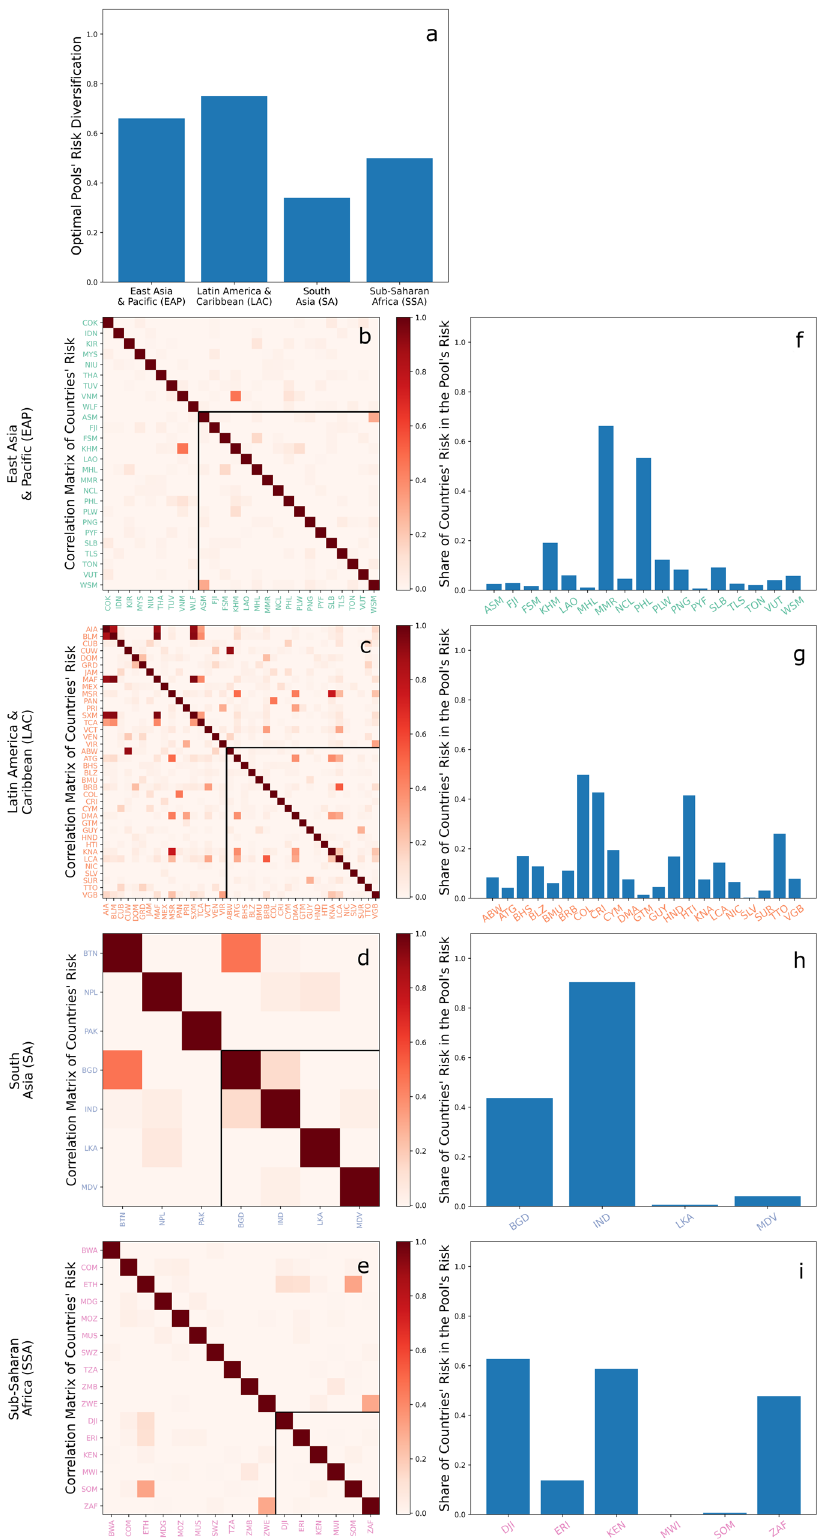
Fig. 1 | Results for the optimal regional pools in the East Asia & Paci fi c (EAP), Latin America & Caribbean (LAC), South Asia (SA) or Sub-Saharan Africa (SSA) regions. a shows risk diversi fi cation of the four regional optimal pools. b – e show correlation matrices and the share of countries ’ risk contributing to the pool ’ s risk within each region. The correlation matrixes show the Pearson correlation coef fi - cientforimpactswithareturntimeof200-yorhigherforallcountriesintheregion